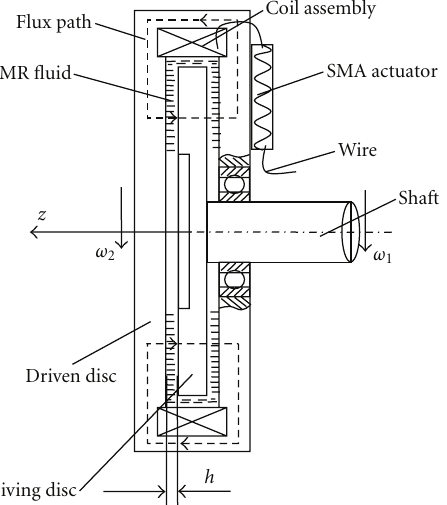
Figure 1: Operational principle of the MR continuously variable transmission system.